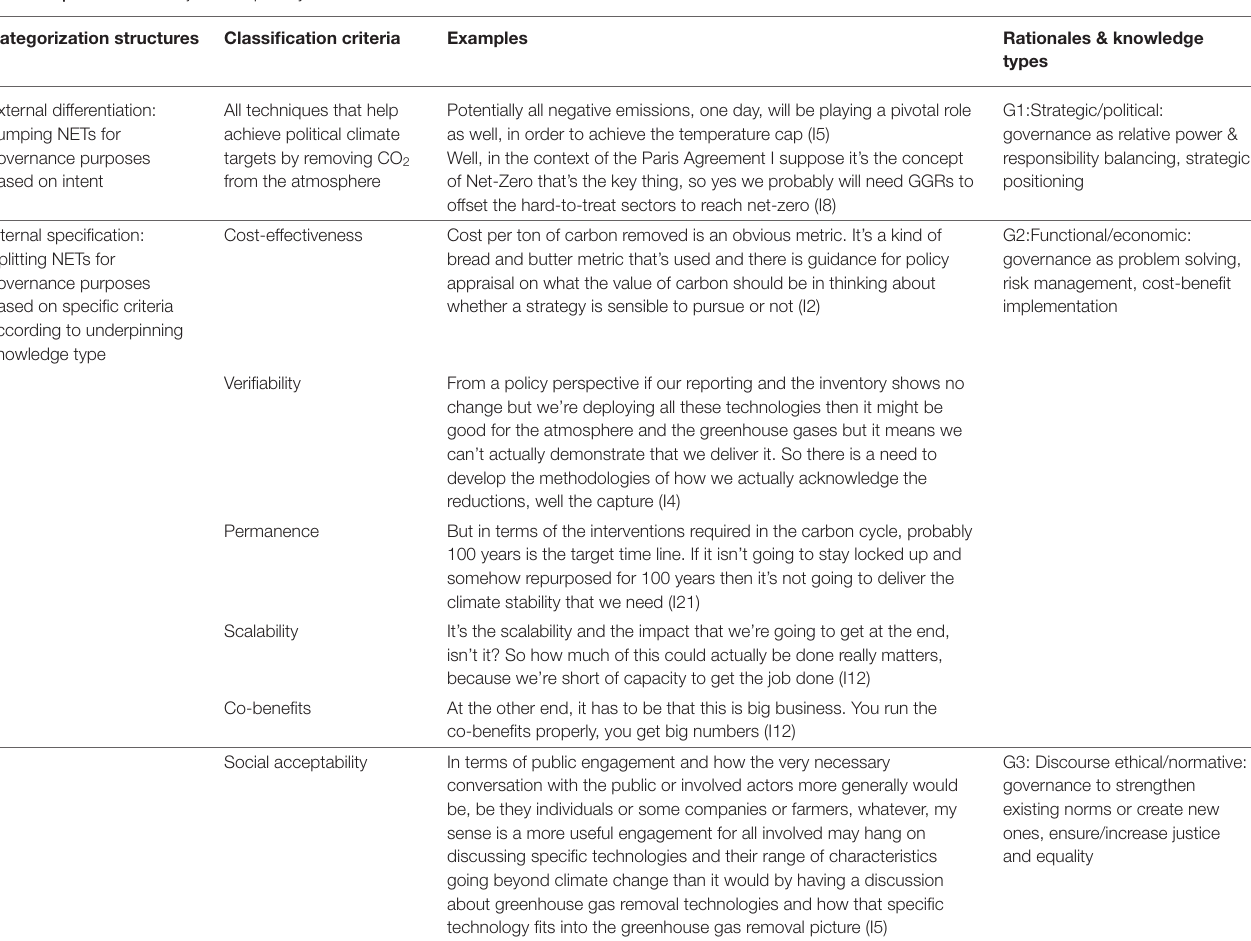
TABLE 3 | Governnace objects shaped by discusive